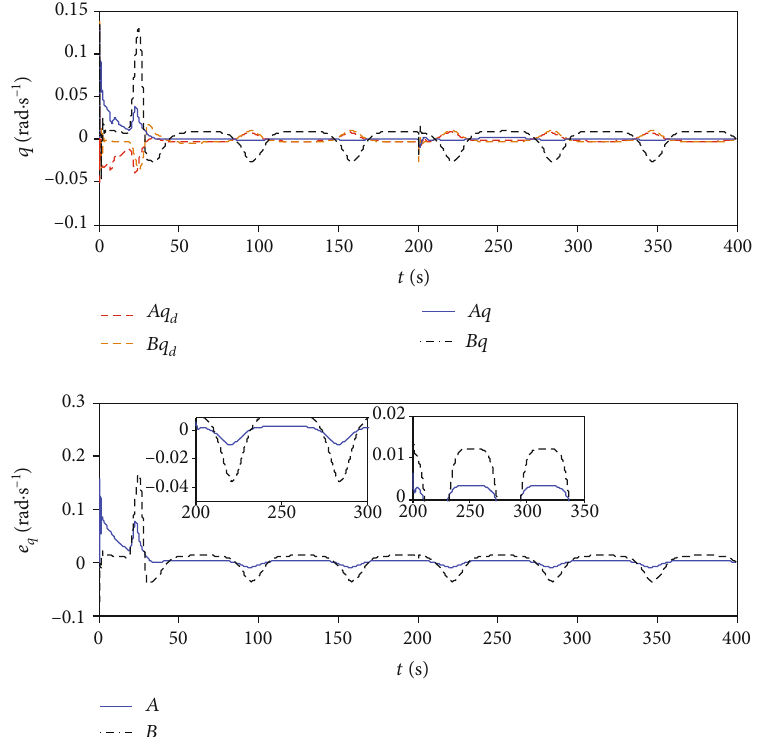
Figure 5: Curves of pitch rate and its tracking error.